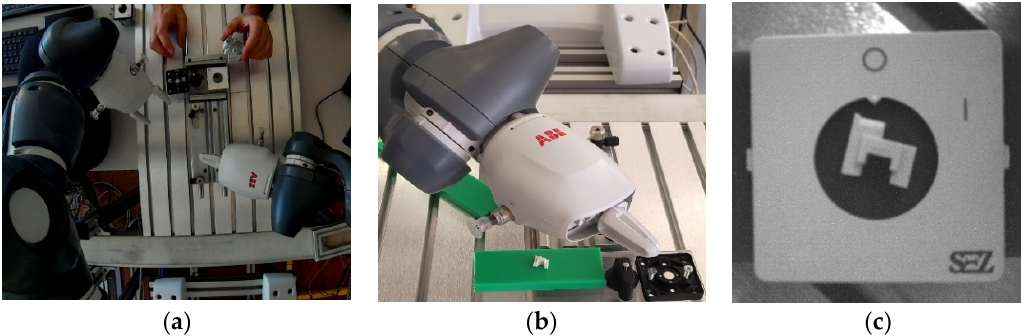
Figure 16. The principle of an experimental assisted assembly work cell with CNN processing unit, mixed reality device, and collaborative robot.